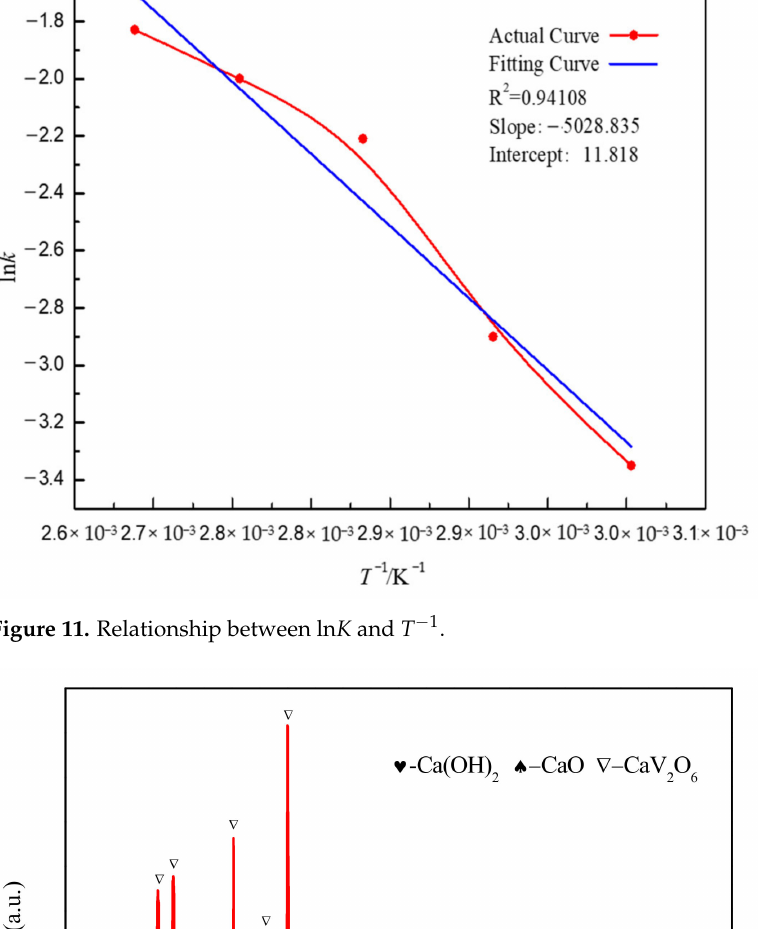
Figure 11. Relationship between ln K and T − 1 .